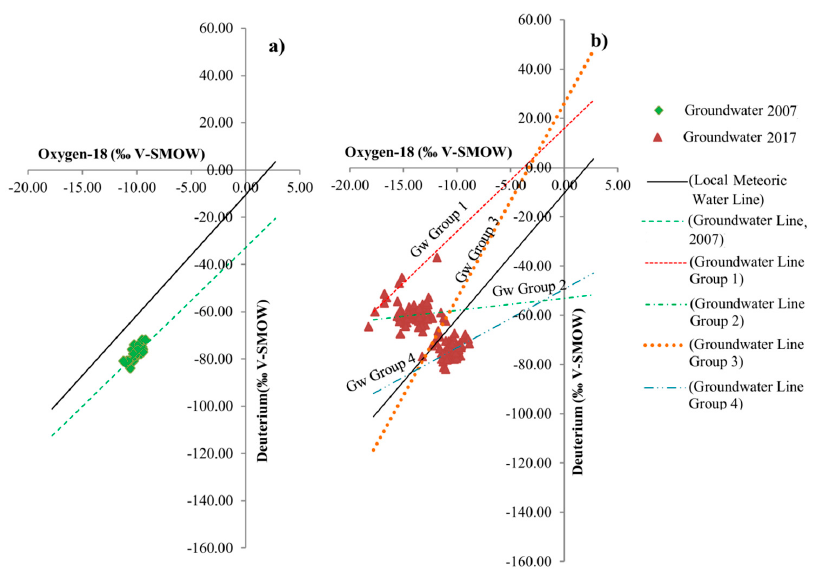
Figure 8. Stable isotopic composition of groundwater sampled in 2007 ( a ) and sampled in 2014–2015 ( b ).